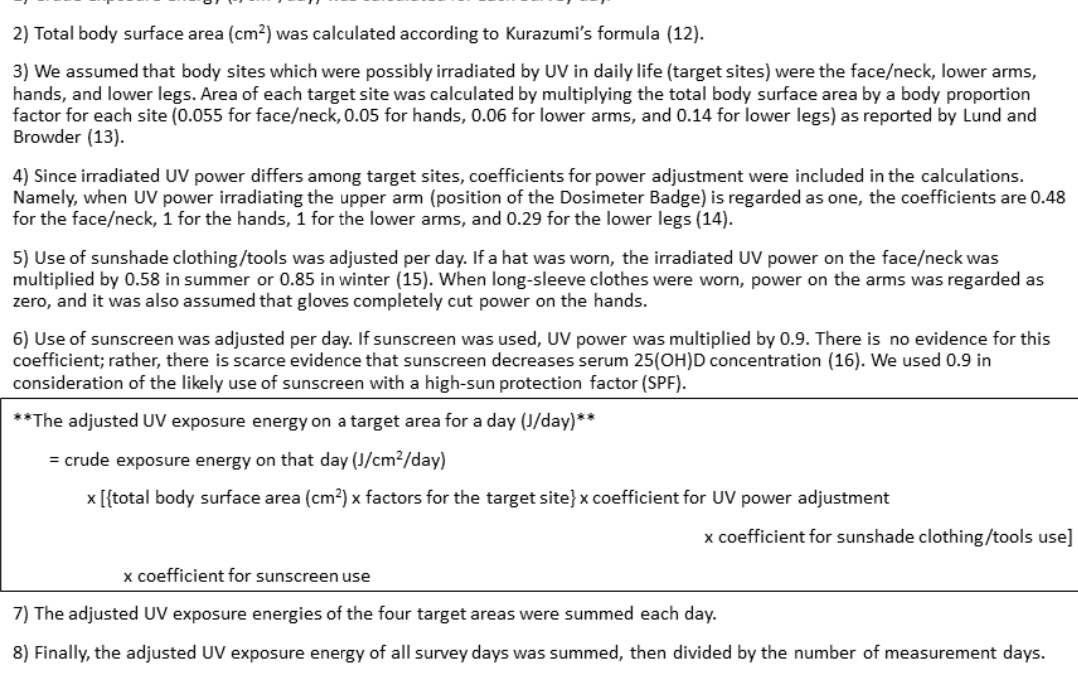
Figure 2. Calculation of adjusted UV exposure energy (J / day). Reference numbers correspond to those in the text.